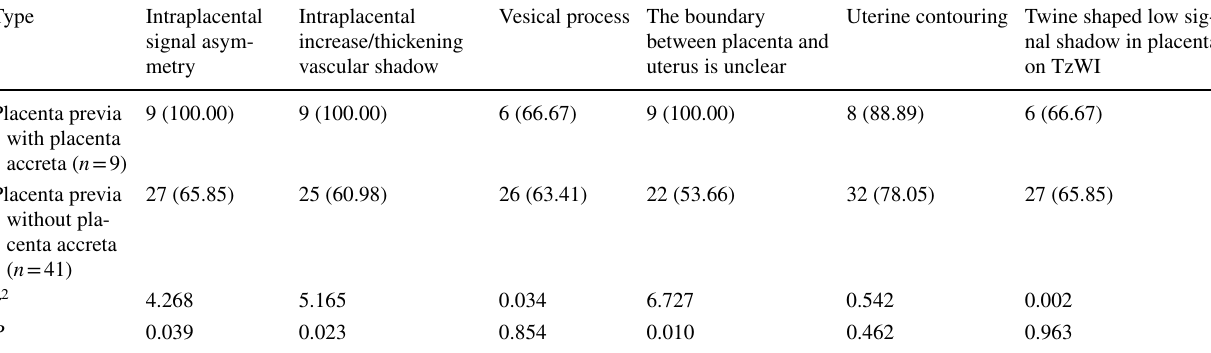
Table 5 Comparison of images of pregnant women with placenta previa and placenta accreta diagnosed by MRI [n/%]